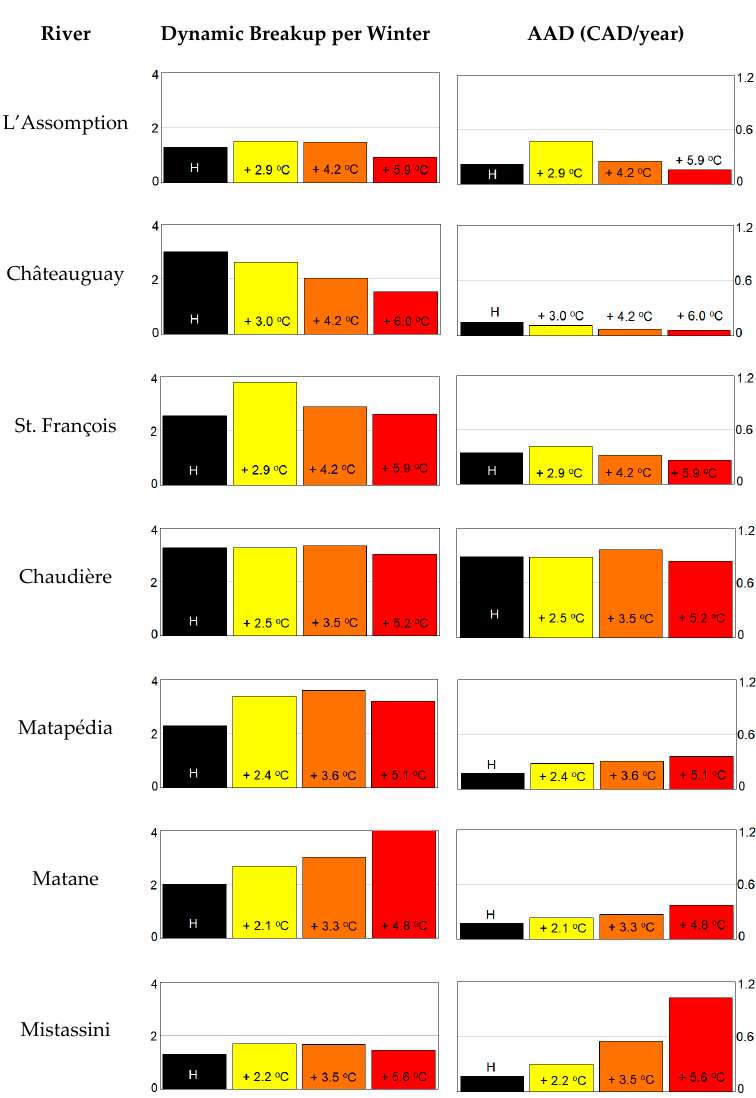
Figure 6. Summary of the frequency of dynamic breakup per year and of the annual risk (AAD) associated with ice jam floods for each studied river. The black data set represents the historical period, and the yellow, orange and red data sets represent different averaged temperature-change intensities.